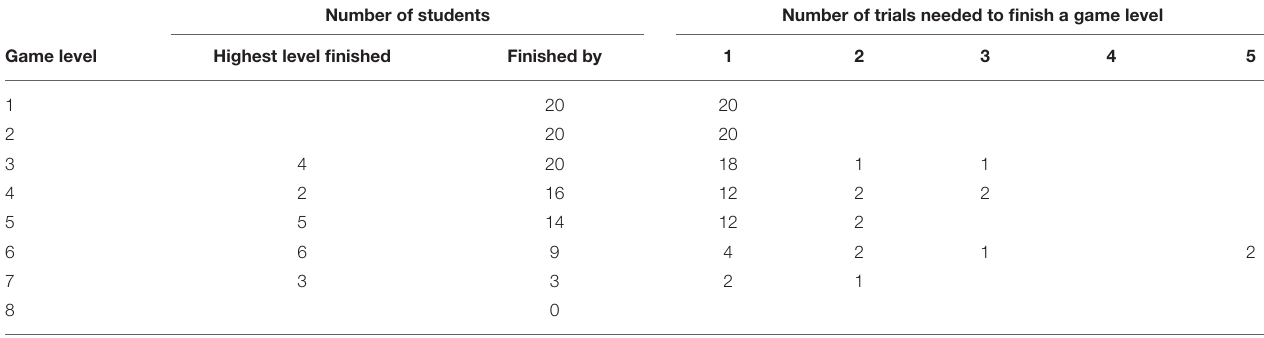
TABLE 7 | The number of students and the trials needed to complete each game level. Number of students Number of trials needed to finish a game level